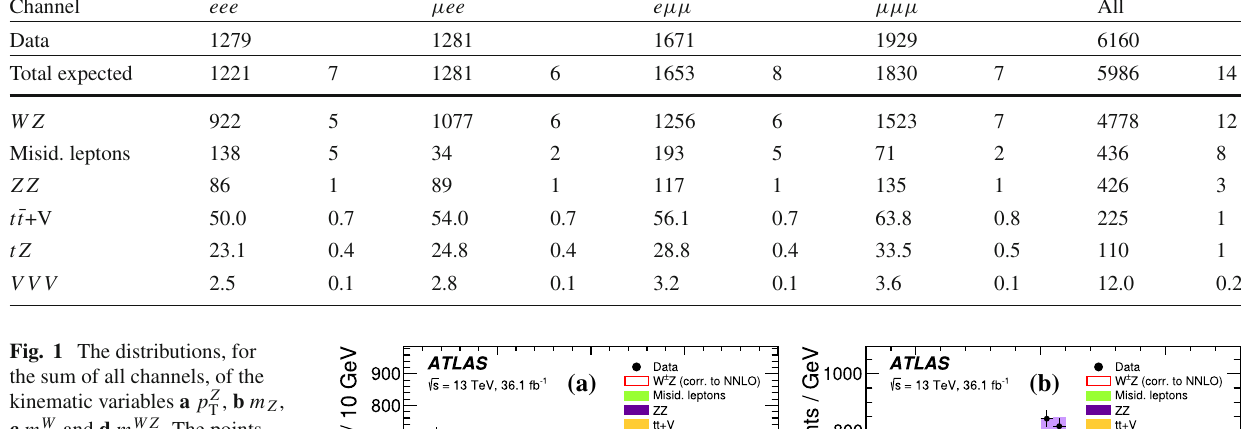
Fig. 1 The distributions, for the sum of all channels, of the kinematic variables a p Z , b m Z , T c m W and d m WZ . The points T T correspond to the data with the error bars representing the statistical uncertainties, and the histograms correspond to the predictions of the various SM processes. The sum of the background processes with misidentified leptons is labelled “Misid. leptons”. The Powheg+Pythia MC prediction is used for the W ± Z signal contribution. It is scaled by a global factor of 1 . 18 to match the NNLO cross section predicted by MATRIX . The open red histogram shows the total prediction; the shaded violet band is the total uncertainty of this prediction. The last bin contains the overflow. The lower panels in each figure show the ratio of the data points to the open red histogram with their respective